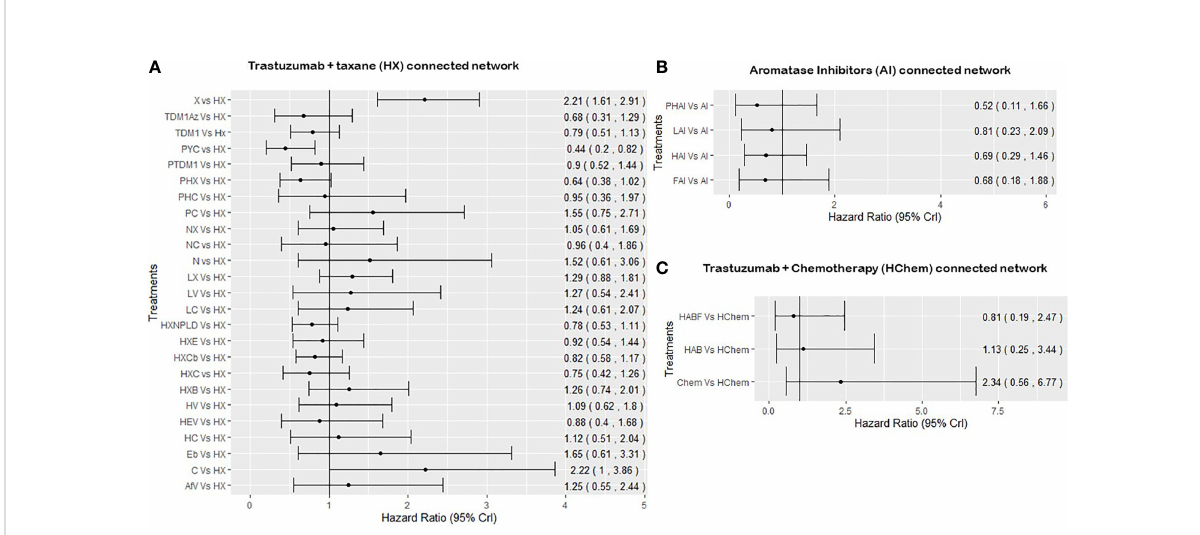
FIGURE 3 Summary forest plots obtained from the NMA including all RCTs for PFS. PHC, pertuzumab + trastuzumab + capecitabine; PC, physician choice; LC, lapatinib + capecitabine; TDM1, trastuzumab emtansine; C, capecitabine; PYC, pyrotinib + capecitabine; LV, lapatinib + vinorelbine; HC, trastuzumab + capecitabine; N, neratinib; TDM1AZ, trastuzumab emtansine + atezolizumab; NX, neratinib + taxane; X, taxane (paclitaxel or docetaxel);NC, neratinib + capecitabine; HX, trastuzumab + taxane; HXB, trastuzumab + taxane + bevacizumab; LX, lapatinib + taxane; HV, trastuzumab + vinorelbine; HXE, trastuzumab + taxane + everolimus; PHX, pertuzumab + trastuzumab + taxane; HXC, trastuzumab + capecitabine + taxane; AfV, afatinib + vinorelbine; HEV, trastuzumab + everolimus + vinorelbine; HXCb, trastuzumab + taxane + carboplatin; PTDM1, pertuzumab + trastuzumab emtansine; Chemo, standard chemotherapy; LH, lapatinib + trastuzumab; L, lapatinib; AI, aromatase inhibitors (letrozole or anastrozole); LAI, lapatinib + AI; FAI, fulverstrant + AI; HAI, trastuzumab +AI; PHAI, pertuzumab + trastuzumab +AI;